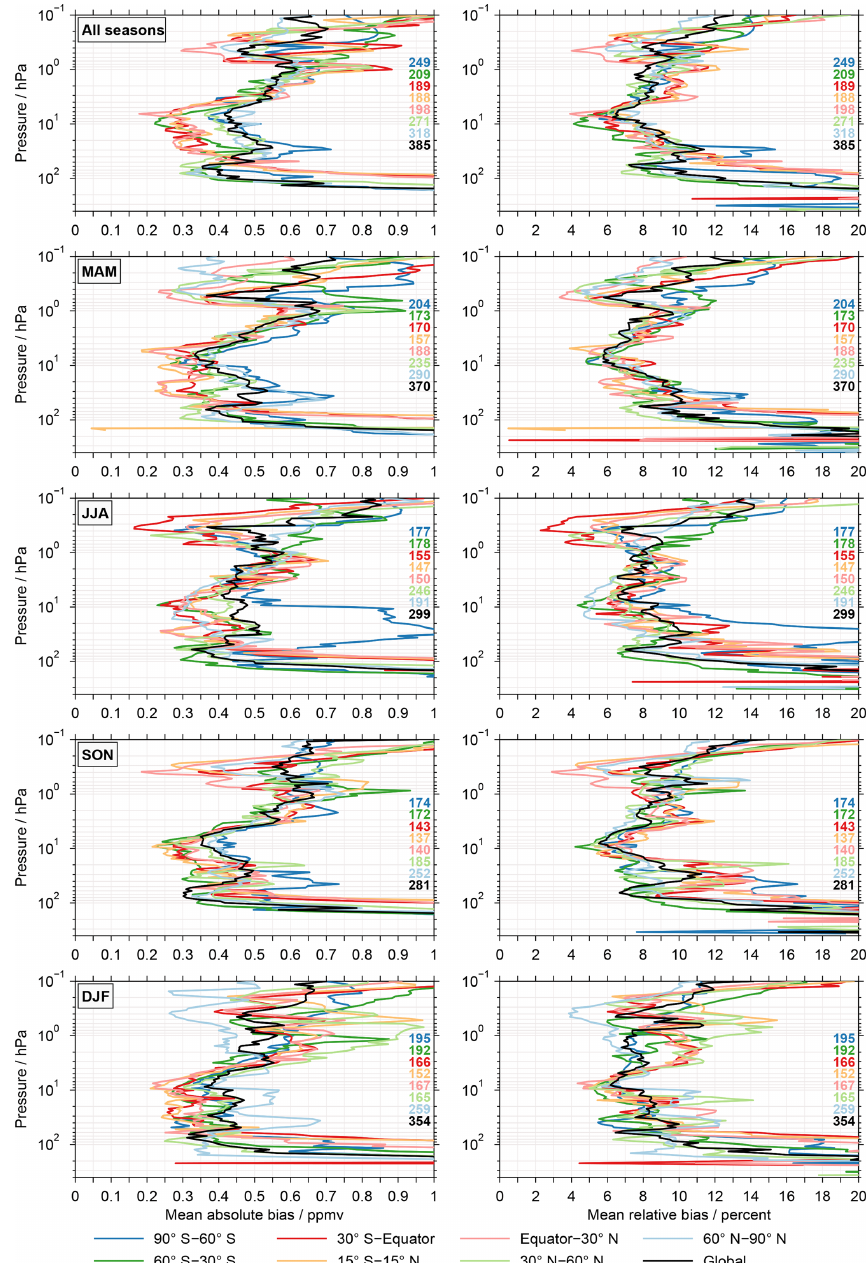
Figure 6. The 50% percentile (median) of the biases from all available comparisons for different times and latitude bands, considering the aggregation of the MIPAS results. The left column considers the absolute biases, the right column the relative biases. The different rows focus on individual seasons or their combination. The results for the different latitude bands are colour coded. On the right-hand side of the individual panels the number of comparisons contributing to the results are indicated. Here, the comparisons with the different MIPAS data sets are counted individually and not combined into a single